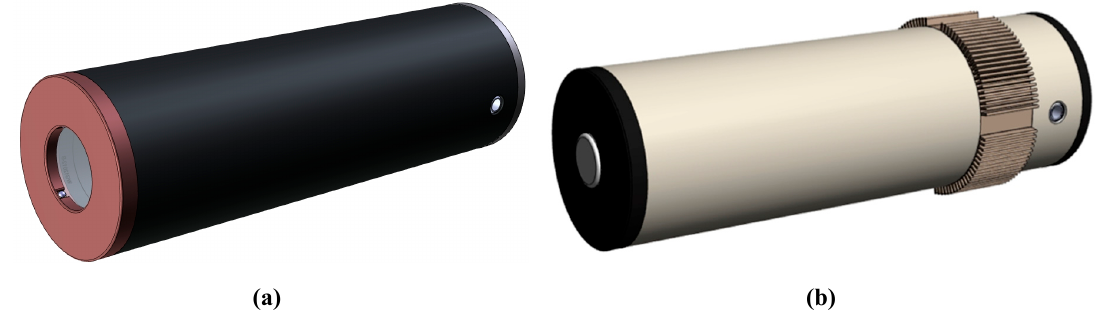
Figure 20. Computer assisted predesign of (a) the radiance instrument with the front optics, copper plate, ultraviolet (UV) light-emitting diode (LED) and the depth sensor and (b) the above-surface irradiance sensor with the cosine collector and the thermal cooling interface (radiator).